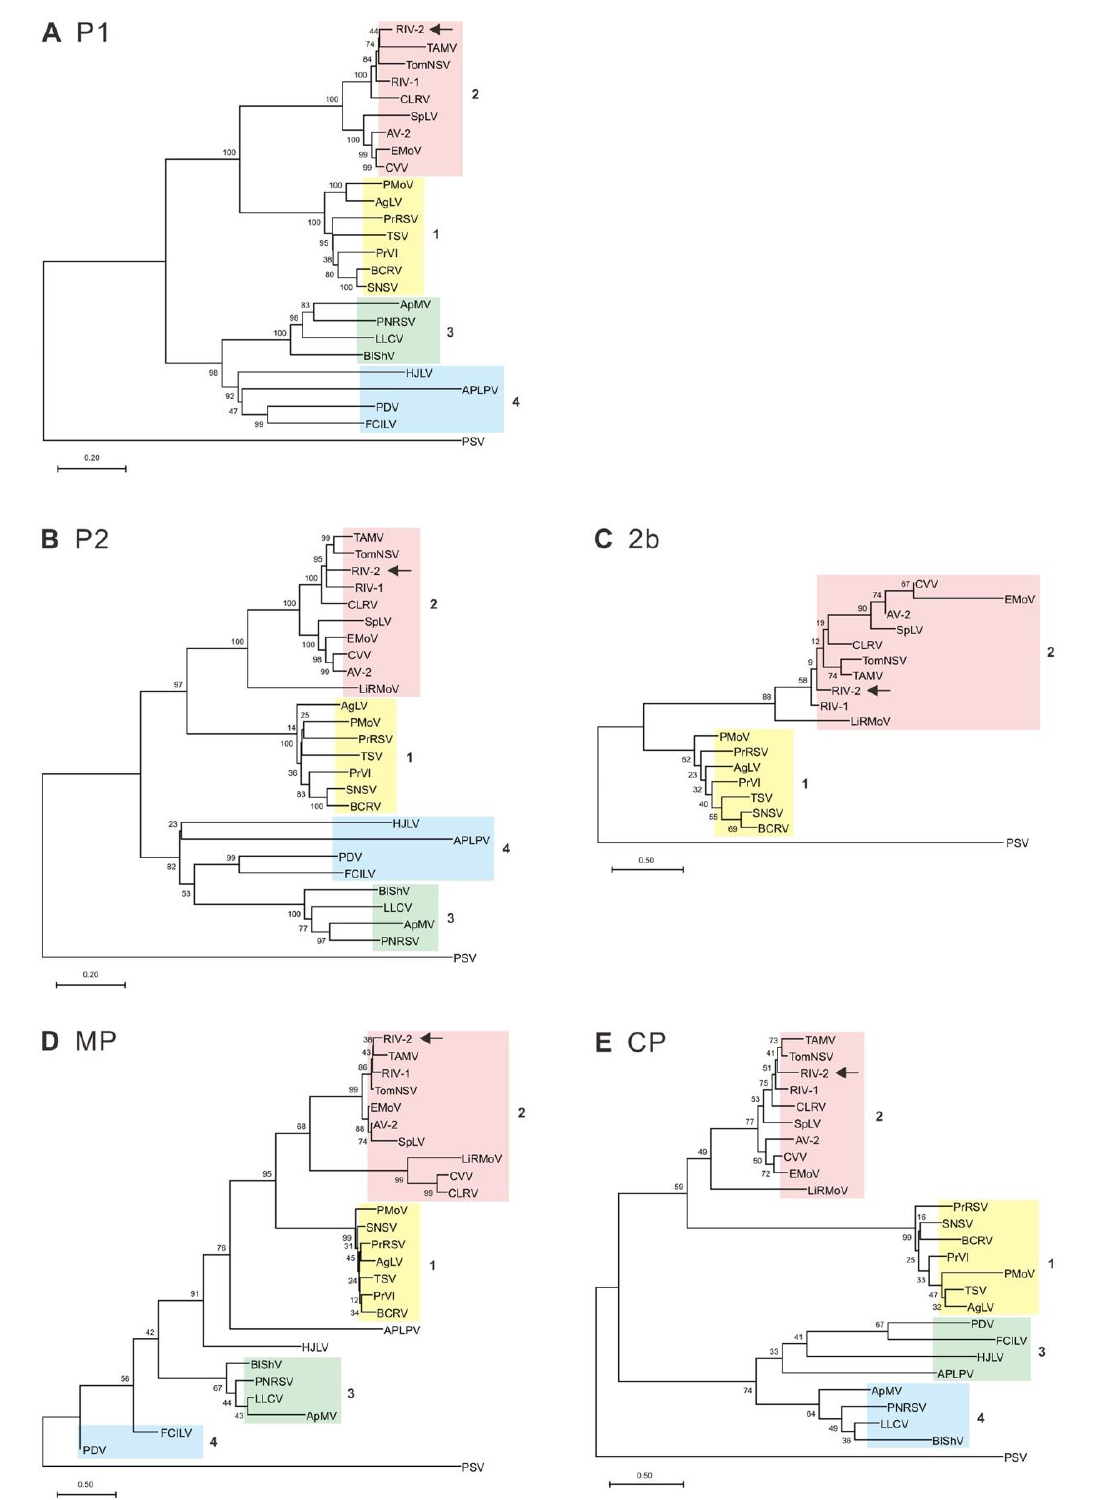
Figure 4. Phylogenetic relationship of the amino acid sequences of ( A ) P1 protein, ( B ) P2 protein, ( C ) 2b protein, ( D ) movement protein (MP) and ( E ) coat protein (CP) of rose ilarvirus 2 (RIV-2) and other ilarviruses. The dendrograms were produced using the Neighbor-Joining algorithm with 1000 bootstrap replicates. Scale refers to amino acid substitutions per site. PSV was used as an outgroup. The newly characterized RIV-2 in this study is indicated by arrows. Subgroups assigned based on additional 2b proteins and phylogenetic relationships are represented by numbers. See Table S3 for virus